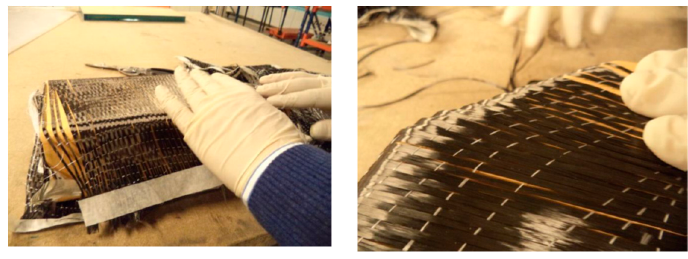
Figure 15. Initial draping tests.